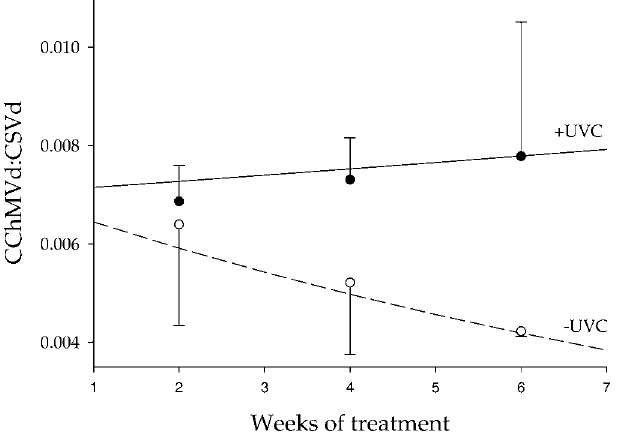
Figure 1. Competition Experiments among CChMVd and CSVd under Normal and Mutagenic Environmental Conditions Black dots represent þ UVC treatment while open dots represent control treatment. Each dot represents the median of the ratios estimated for multiple plants. Error bars represent the jackknife estimate of the standard error of the median. The lines represent the best fit to the non- linear model described in Materials and Methods.